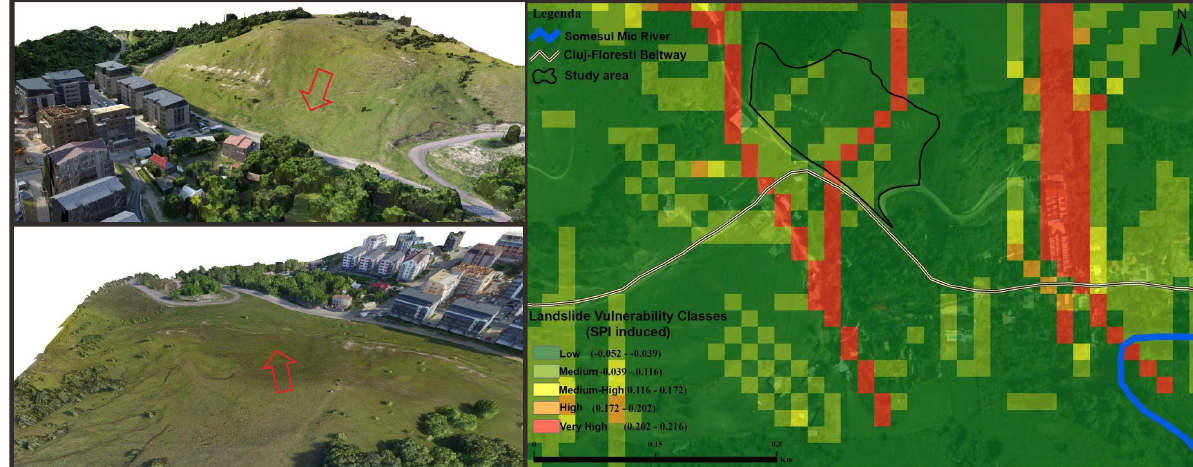
Figure 21. 3D model of the slope with the highest displacement and erosion zone highlighted ( left ); stream power index factor from the bivariate statistical analysis (BSA) susceptibility map ( right